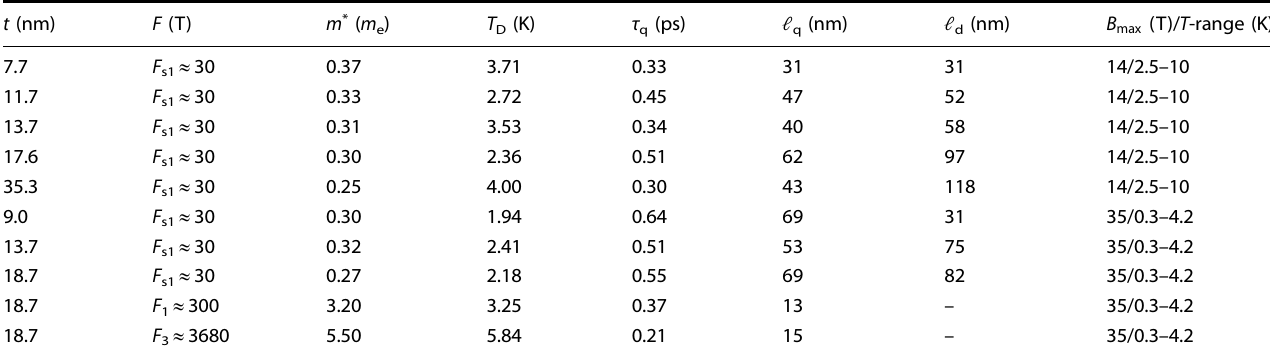
Table 1. A summary of the extracted F , m * , T D , τ q , and ℓ q from the quantum oscillation measurements at T = 2.5 K, where ℓ d values are included for comparison. The maximum fi eld ( B max ) and T -range of the measurement are also listed.